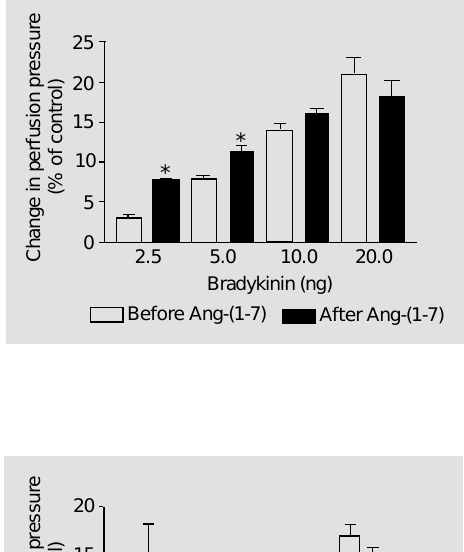
Figure 1 - Effect of bradykinin on isolated rat hearts perfused with Krebs-Ringer solution and Krebs- Ringer containing Ang-(1-7) (2.2 nM). Values are reported as per- cent change in basal perfusion pressure. *P<0.05 compared to bradykinin alone (ANOVA fol- lowed by the least significant test).